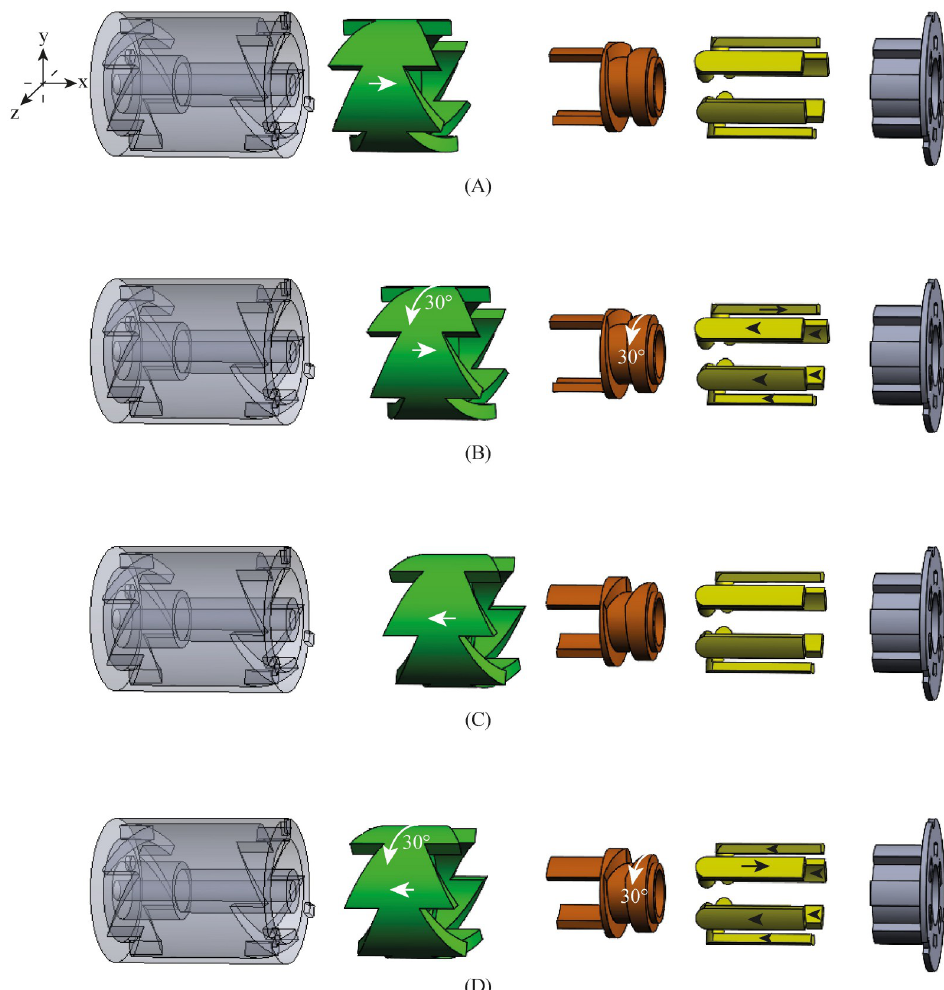
Fig 5. Schematic motion sequence of the selector in 3D, including the selector (green), housing (grey), cam (orange), and needle segment holders (yellow).